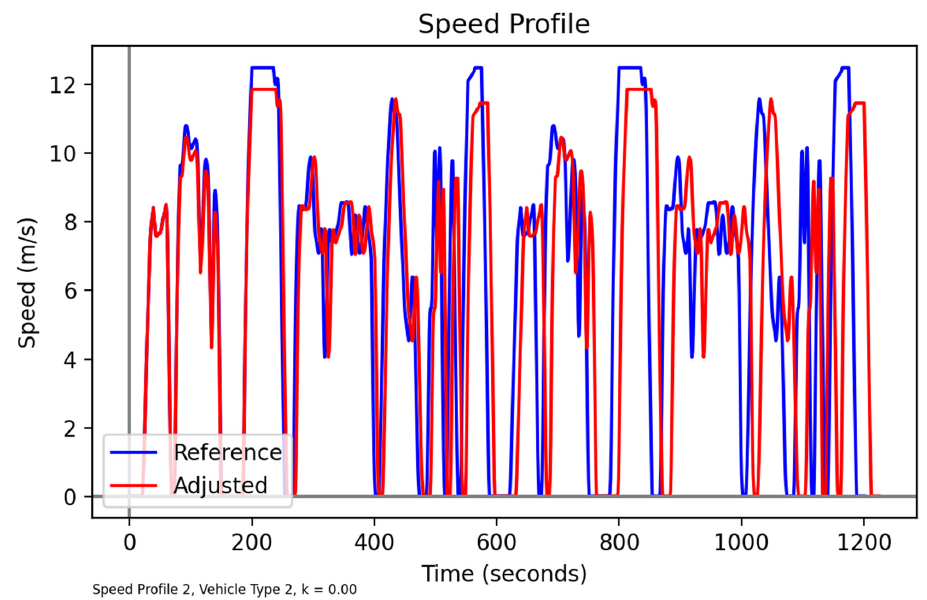
Figure 6. Adjusted speed profile for electric quadricycle in comparison with reference cycle (WMTC Reference Cycle 2, Vehicle Type 2, Flat terrain assumed in adjustment).